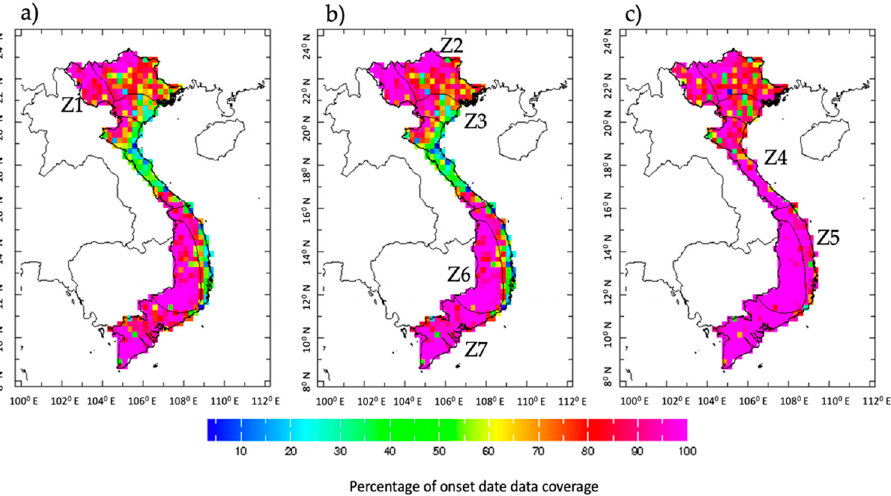
Figure 2. Onset date data coverage for search window for the rainy season set to ( a ) April 15th, ( b ) April 25th, and ( c ) August 5th. Coverage is shown as a percentage, where 100% is a grid point which satisfies the agronomic definition for all years of the 1980–2010 period.